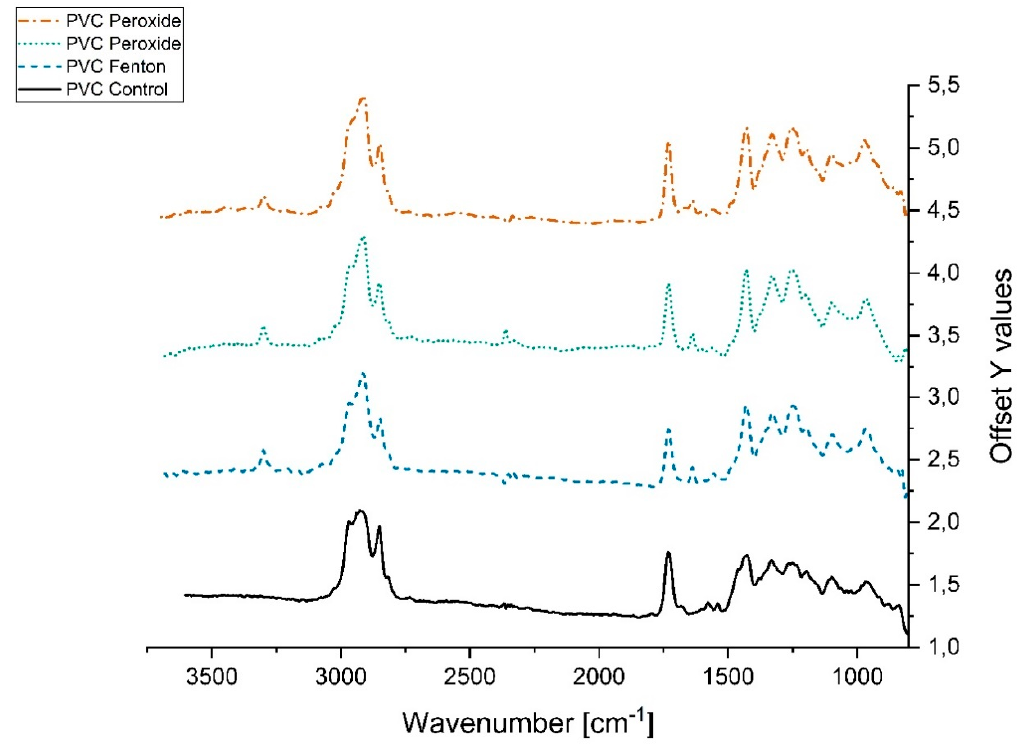
Figure A3. µ FTIR Spectra of Figure A3. µFTIR Spectra of PVC.